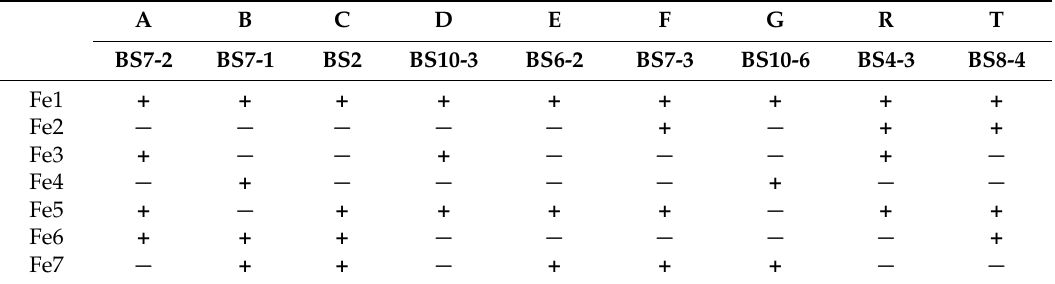
Table 1. The spinsets, that is combinations of signs of the spin densities on Fe atoms, their identifying letter labels used in this work, and the broken-symmetry (BS) identifiers [58].